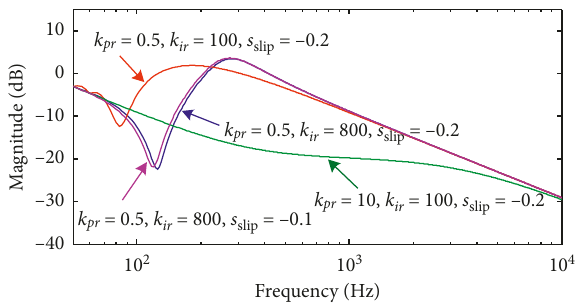
Figure 9: Magnitude-frequency curves of Y